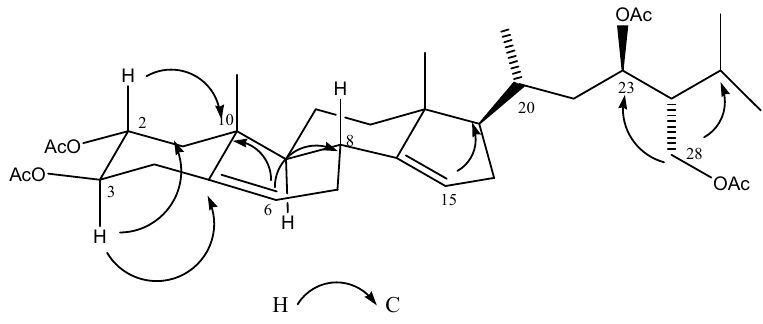
Figure 5. Key HMBC correlations of derivative 3a .